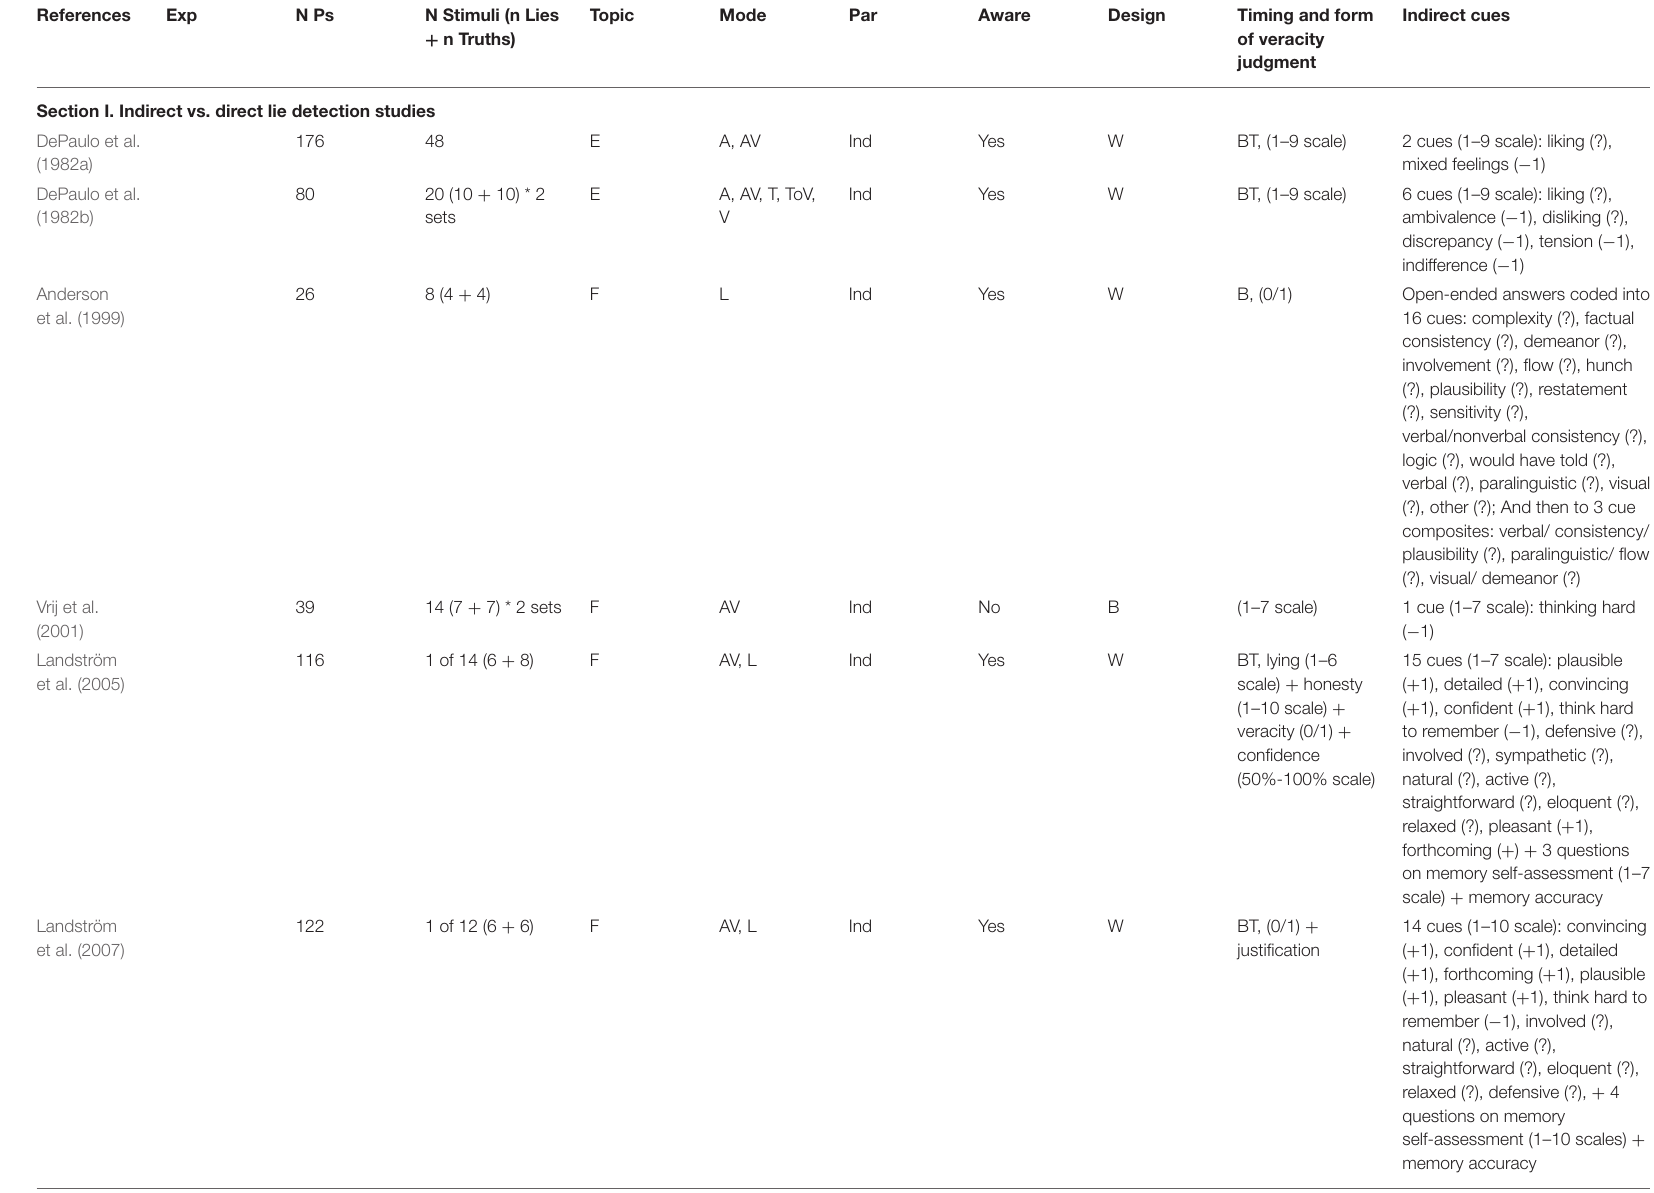
TABLE 1 | Review of experiments on direct vs. indirect lie detection and unconscious vs. conscious lie